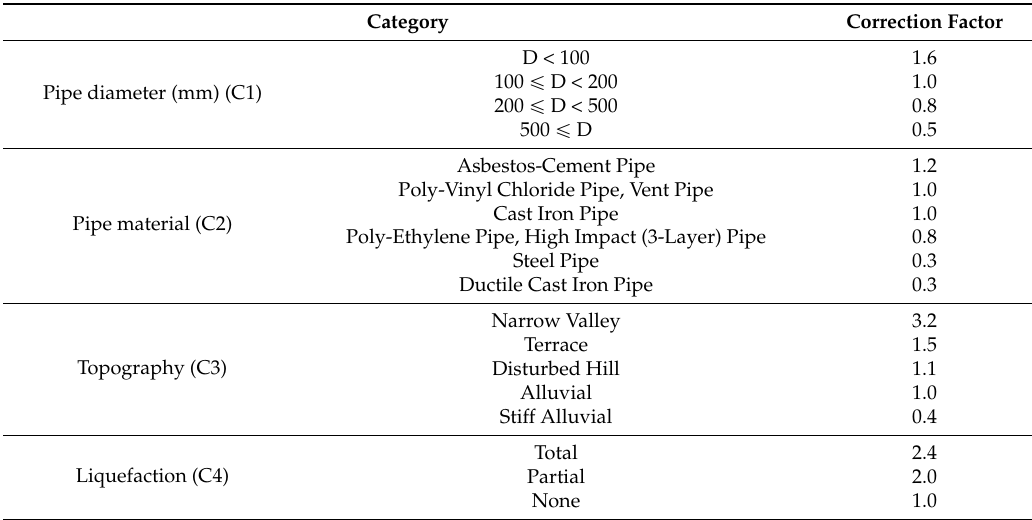
Table 1. Correction factors (Isoyama et al.